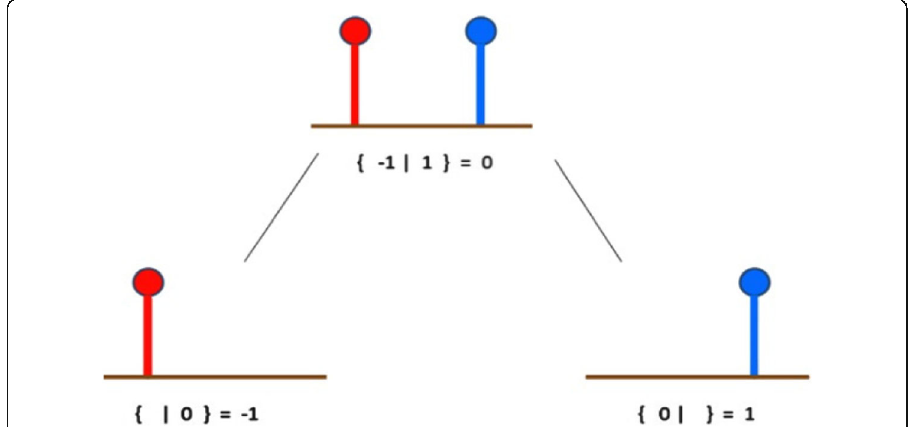
Fig. 4 A simple Hackenbush game tree with